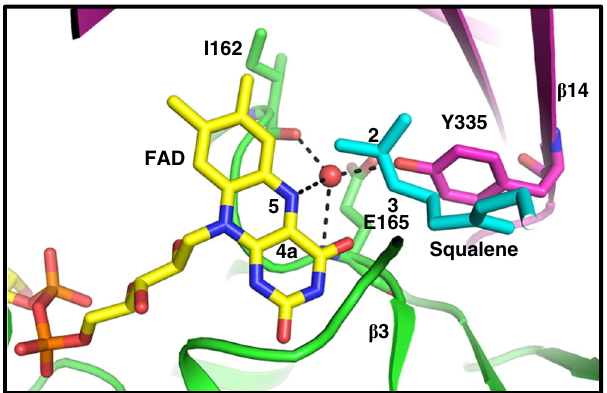
Fig. 7 FAD stabilization and implications for catalysis. FAD stabilization by Y335 water – bridged interaction. Hydrogen bonds to fl avin N5 position to water and its network to Y335, I162, and E165 are illustrated by dashed lines with water shown as a red sphere. FAD (from SQLE (cid:129) FAD (cid:129) Cmpd-4 ′′ complex) and docked, superposed squalene (in cyan) are in stick representation with atom positions 2 and 3 shown as sites of stereo- and regio-speci fi c